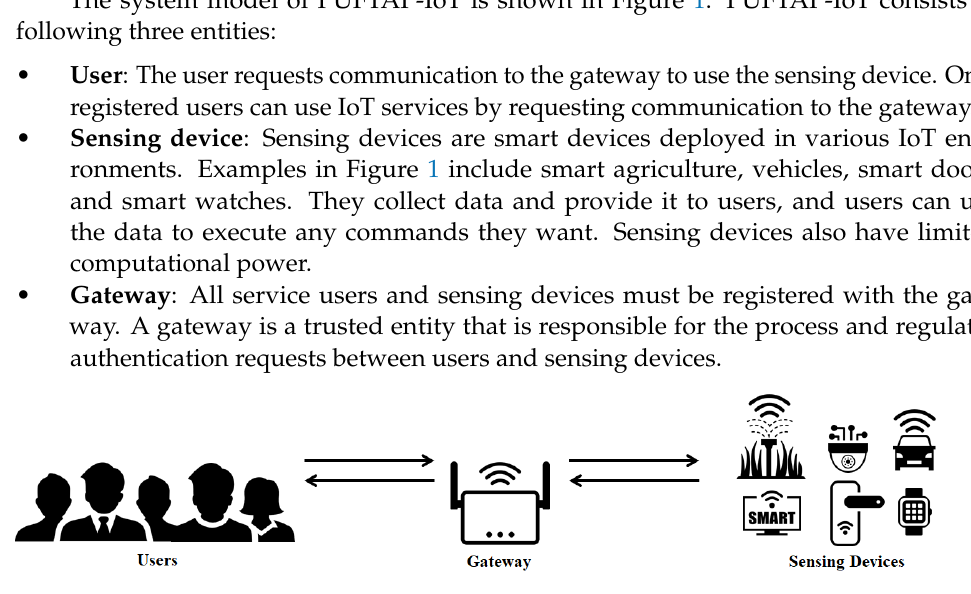
Figure 1. PUFTAP-IoT’s system